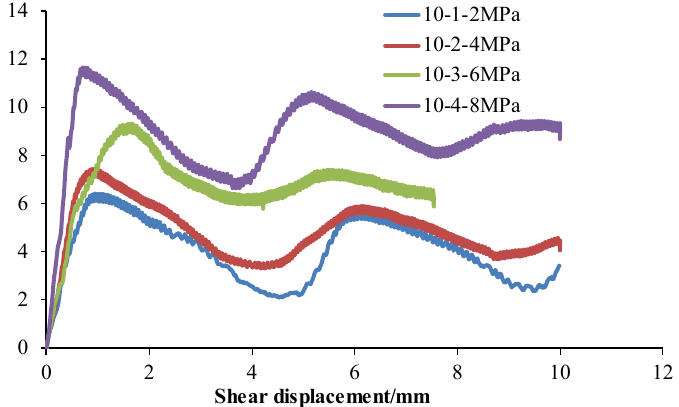
Figure 5. Shear stress–displacement curves under different normal stresses at a 0.6 mm/min shear rate with a 10° undulating angle.